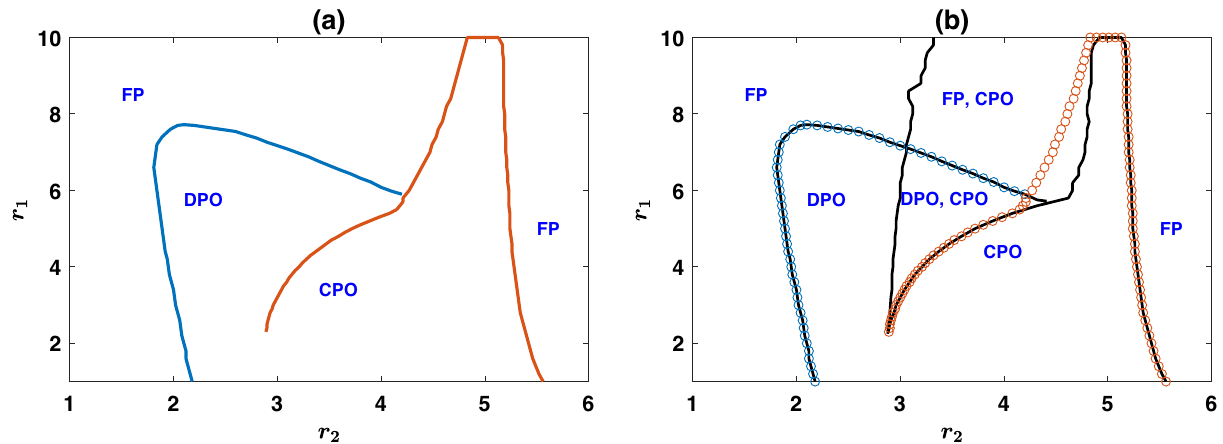
Figure 3. The phase diagram of the assortative public goods game. ( a ) The phase diagram in the r 1 − r 2 plane. For both small and large values of r 2 the model settles into a fixed point (FP). In between, the model shows the cyclic dominance of different strategies. Two different periodic orbits, DPO and CPO, separated by a singular transition exist. ( b ) Different stability regions in the r 1 − r 2 plane (black lines). The phase boundaries are superimposed (empty circles). The model shows two bistability regions where either both the fixed point and the CPO, or both DPO and CPO are stable. Here, g = 10 , ν = 10 − 3 , c = 1 , and π 0 = 2